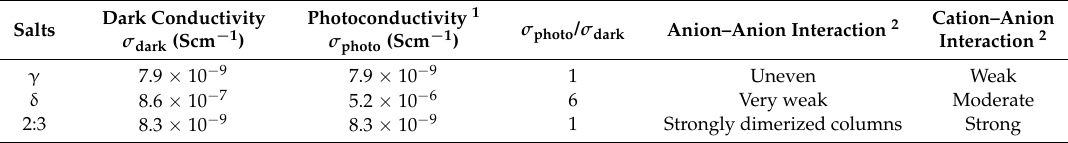
Table 2. Comparison of properties of DiCC salts (DiCC = 3,3 (cid:48) -Dihexyloxacarbocyanine